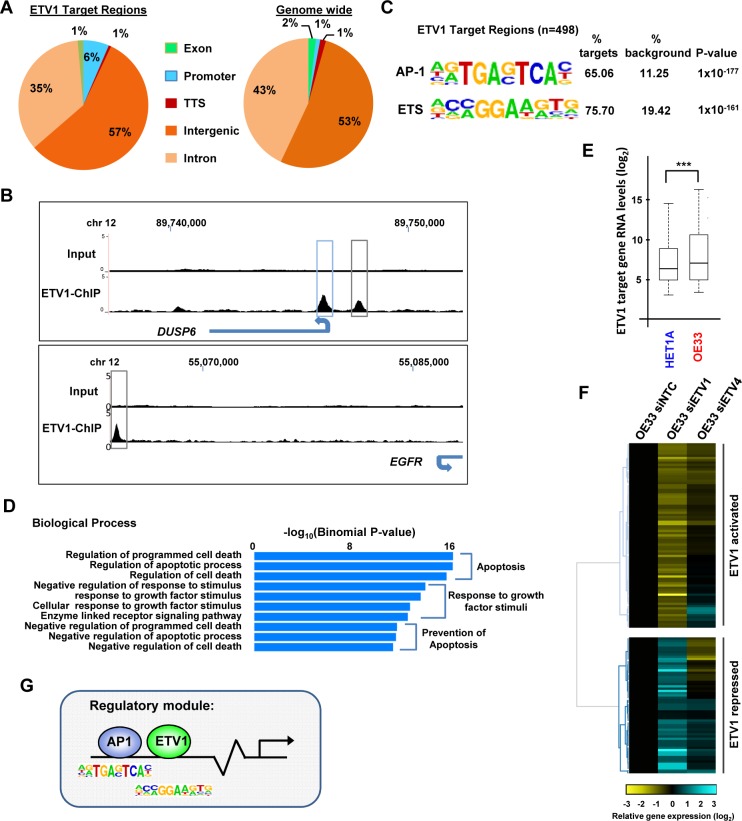
Identification of the ETV1 cistrome in oesophageal adenocarcinoma-derived OE33 cells.(A) Pie charts showing the genomic distribution of the ETV1 binding peaks (left) and the expected ratio of genomic regions (right) (promoter defined as +/- 1 kb from TSS). (B) UCSC browser track showing ETV1 binding peaks (bottom tracks) at the DUSP6 and EGFR loci with enrichment over the input sample (top tracks). Intergenic (grey boxes) and promoter proximal (blue boxes) peaks are highlighted. (C) Top two motifs from de novo motif discovery at the ETV1 binding regions. (D) The top 10 gene ontology terms from the biological processes category of the genes associated with ETV1 binding regions. (E) Box plots showing the average gene expression levels from microarray analysis of the 398 direct ETV1 target genes in HET1A compared to OE33 cells. Horizontal line represents the median values; ***P-value = <0.001 (2 tailed T-test). (F) Heatmap showing gene expression changes of direct ETV1 target genes following siRNA-mediated ETV1 or ETV4 knockdown in OE33 cells. Only genes showing a fold change of >1.5 following depletion of ETV1 are shown. Data are normalised to OE33 treated with a non-targeting control siRNA (siNTC), and clustered. (G) Model showing a potential regulatory module acting at ETV1 binding elements consisting of AP1 and ETV1 transcription factors.